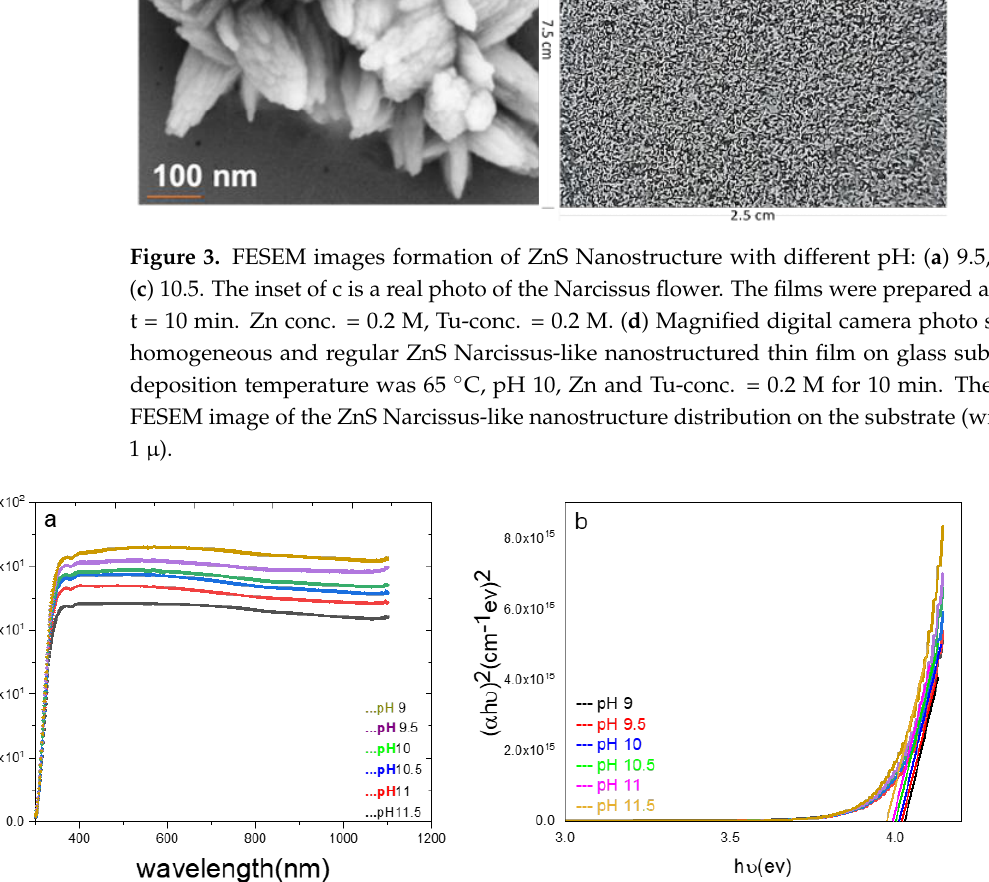
Figure 4. ( a ) The transmittance of ZnS thin films variation with different deposition pH ( b ) the Eg of ZnS thin at different pH levels. Other parameters were fixed at T = 65 °C , td = 10 min, Zn conc = 0.2 M, Tu- conc = 0.2 M.